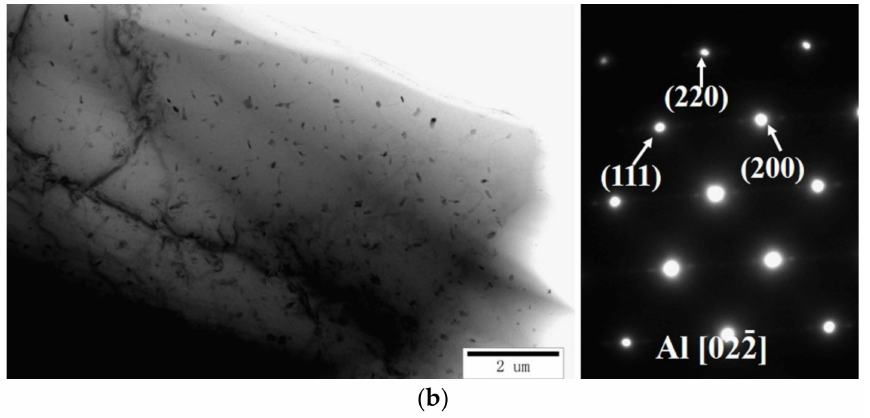
Figure 7. The crystal structure of the non-heat-treated, die-cast aluminum alloy sample: ( a ) before heat treatment; ( b ) after heat treatment.